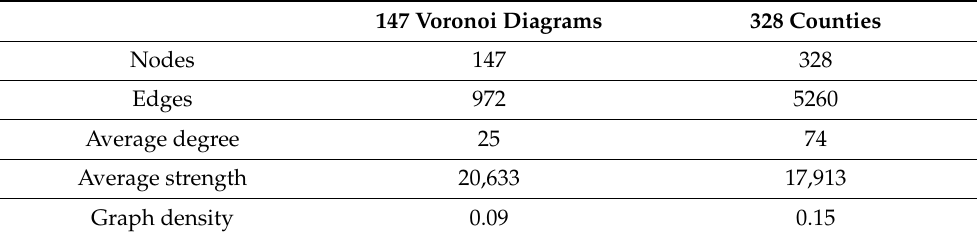
Table 2. Overall network properties of Voronoi diagram and 328